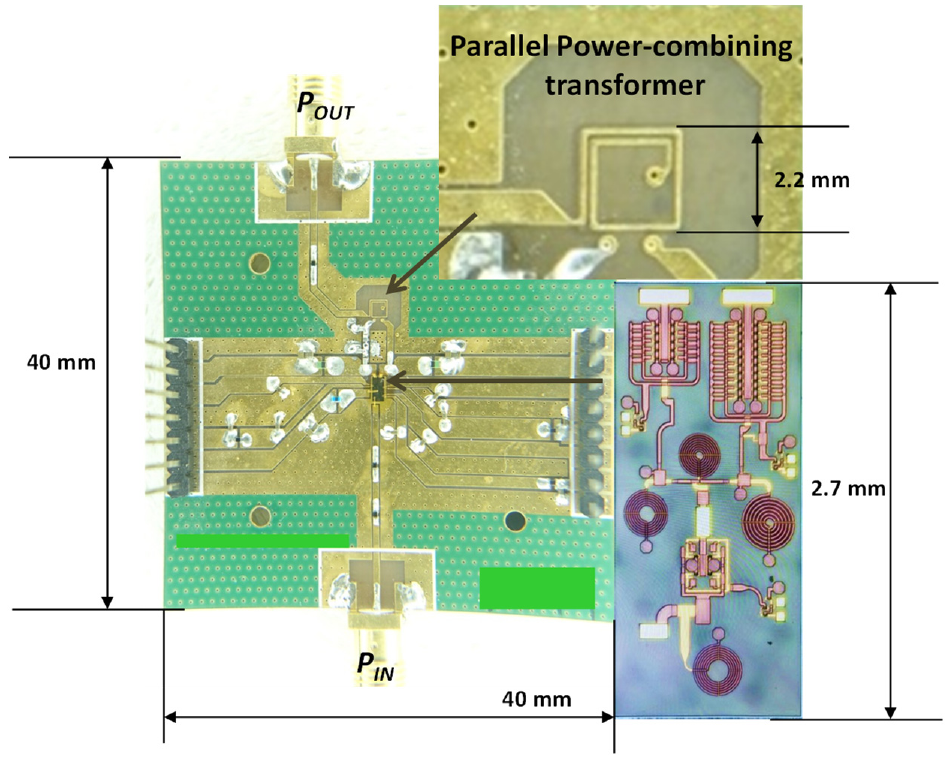
Figure 11. Photograph of the dual-mode HBT PA using PCB PCT. The measured S-parameter results are shown in Figure 12. The implemented PA was tested with a 0.91 GHz single-tone continuous wave (CW). Figure 13 shows the measured power gains and power-added efficiencies (PAEs) of the dual-mode operation (HP and LP modes). Both PA1 and PA2 are turned on for the HP-mode operation. Meanwhile, for the LP mode operation, PA1 is turned on, whereas PA2 is turned off. The measured power gains of the implemented PA are 34.6 dB and 18.9 dB for the HP and LP modes, respectively. The saturated output powers, P SAT , are 33.8 dBm and 22.5 dBm for the HP and LP modes, respectively. The P SAT of the PA is over 2 W with the proposed high- Q parallel power-combining transformer. The peak PAEs for the HP and LP modes are 54.5% and 15.4%,